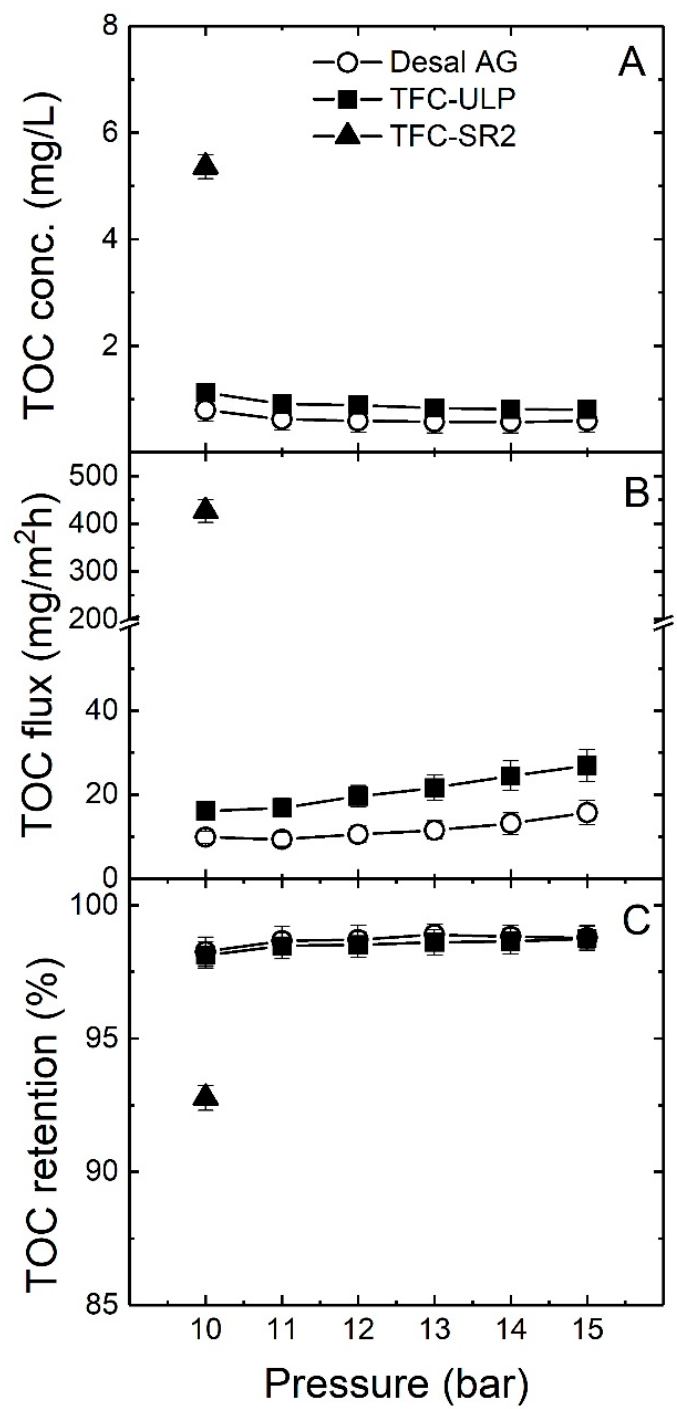
Figure 6. ( A ) Total organic carbon (TOC) permeate concentration, ( B ) TOC flux and ( C ) TOC retention as a function of applied pressure (10–15 bar) with groundwater sample 5 (feed TOC concentration 70.9 mg / L). The pH was about 9, data adapted from [69].